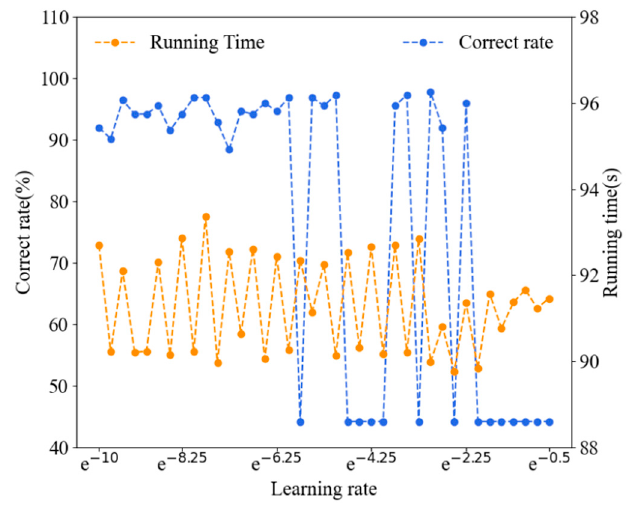
Figure 10. Performances of fault diagnosis based on the VGG-PCA model with different learning rates.